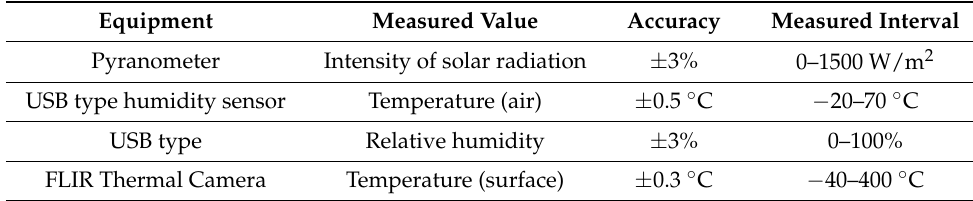
Table 5. Measuring